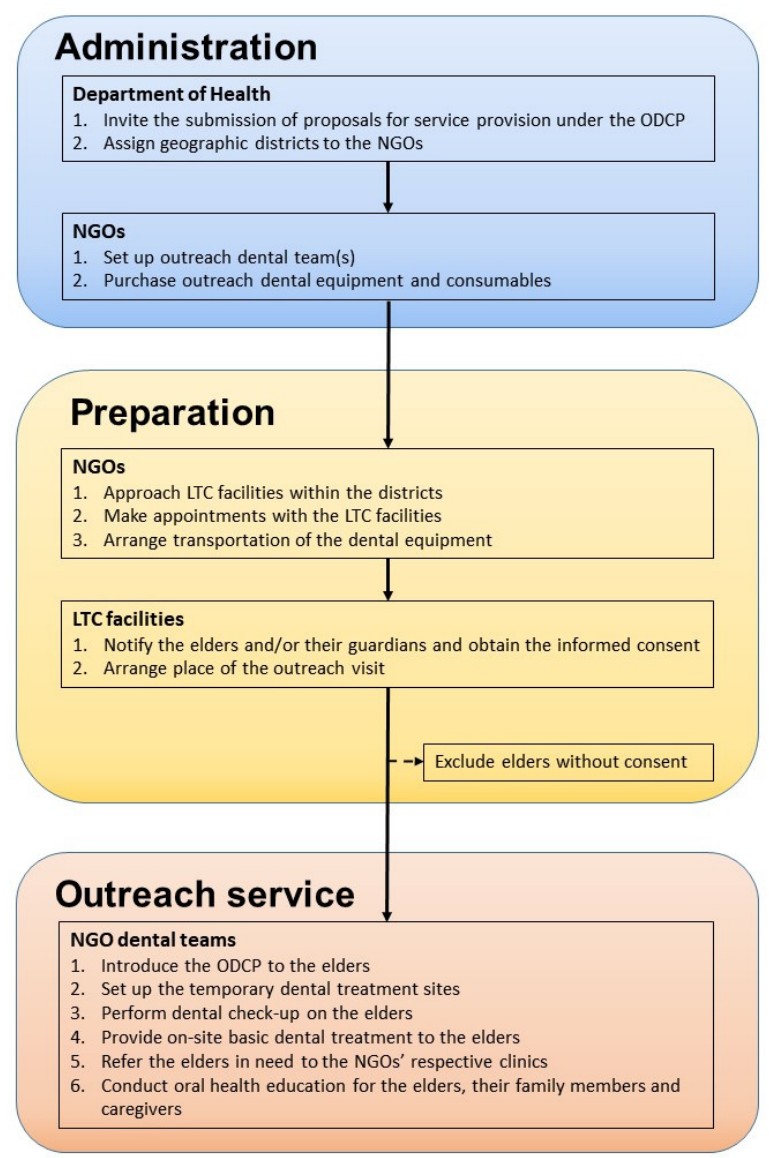
Figure 2. The flow of the activities of the outreach dental care programme for older